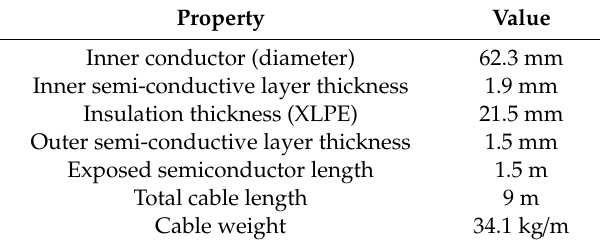
Table 1. HVDC cable properties.